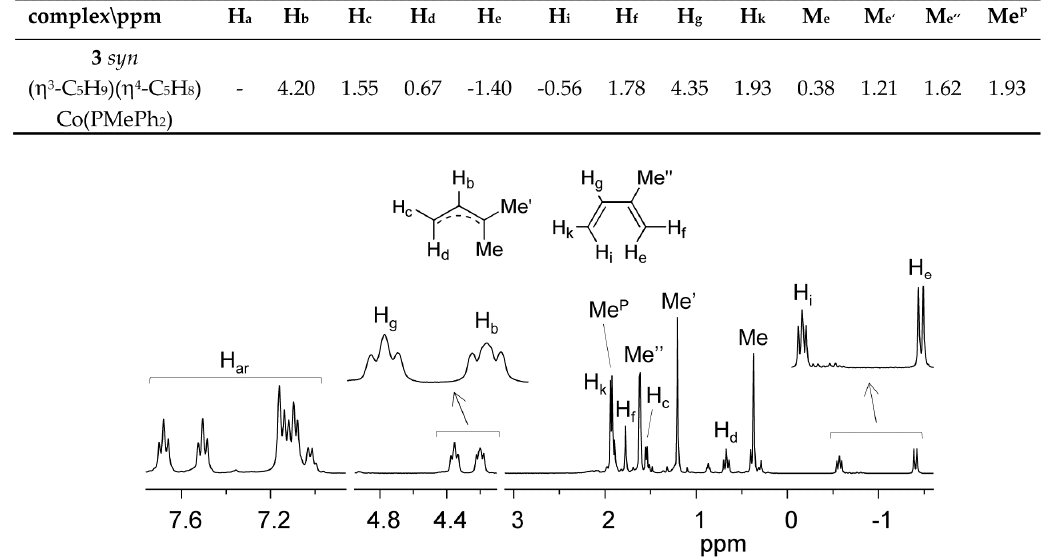
η 4 -C 4 H 7 )( 4 H 6 )Co(PCyPh 2 ) ( 1 ).